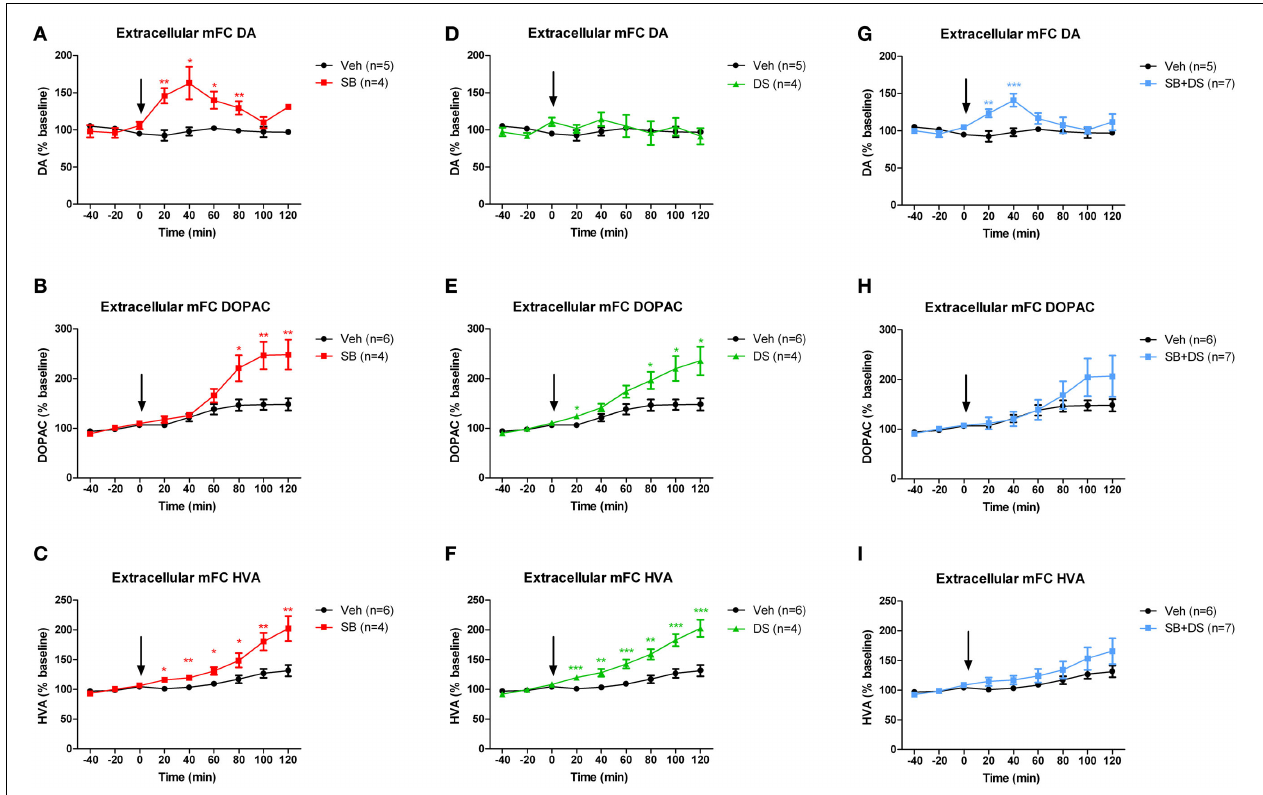
FIGURE 3 | Dopamine (DA) and its metabolites DOPAC and HVA in medial frontal cortex (mPFC) after injection of sodium benzoate (SB), D-serine (DS), the combination (SB + DS), or vehicle (Veh), into the rat VTA. (A–C) Effects of sodium benzoate, showing increases in DA (A) , DOPAC (B) , and HVA (C) . (D–F) Effects of D-serine, showing